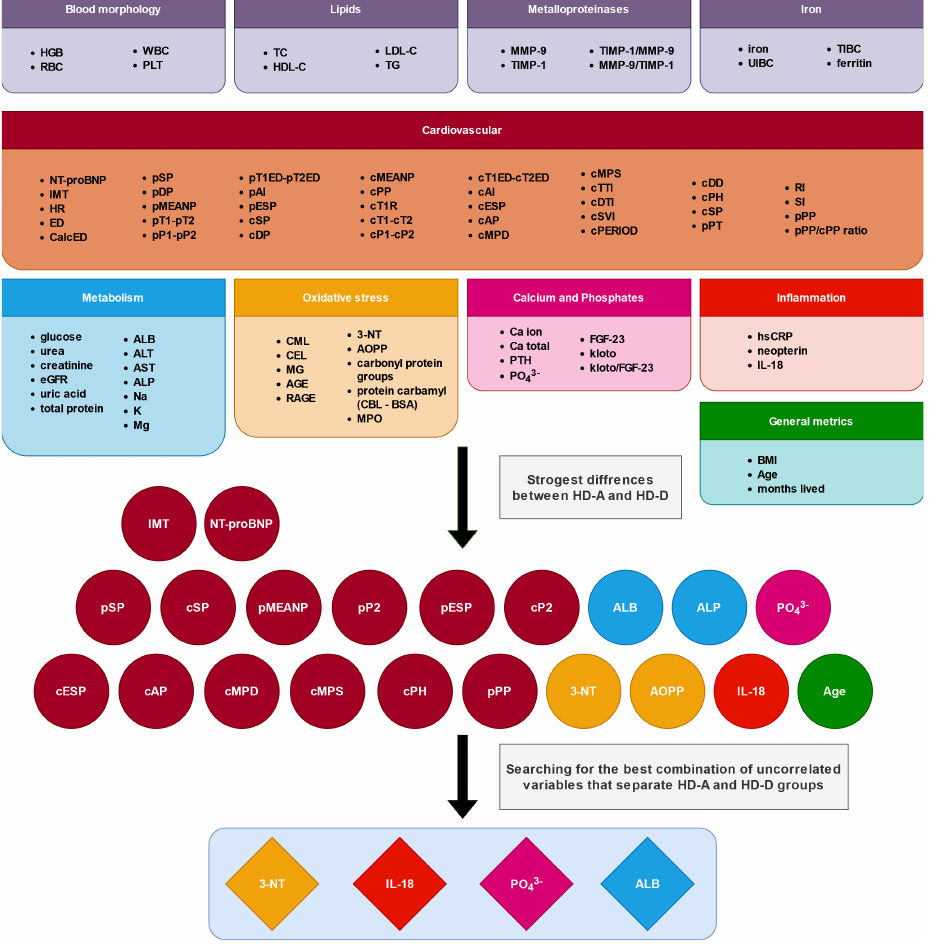
Figure 1. Stages of variable selection for the creation of the final model. We have distinguished 10 cat- egories of variables: blood morphology, lipids, metalloproteinases, iron, cardiovascular, metabolism, oxidative stress, calcium and phosphates, inflammation, and general metrics. Four categories ware completely rejected based on the Kruskal–Wallis test results. Spearman correlation and experimental model fitting helped to find the best combination of variables that differentiate the HD-A and HD-D groups (4 out of